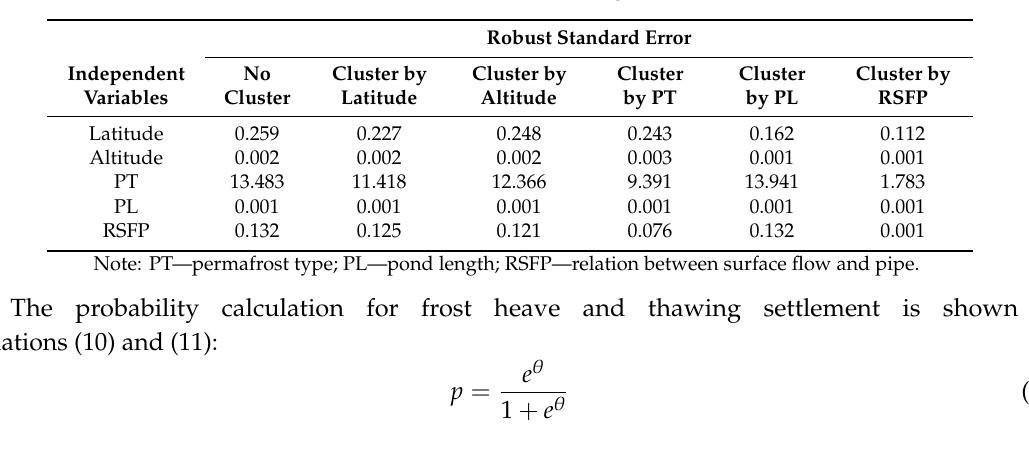
Table 4. Clustered robust standard errors of the regressed freeze–thaw